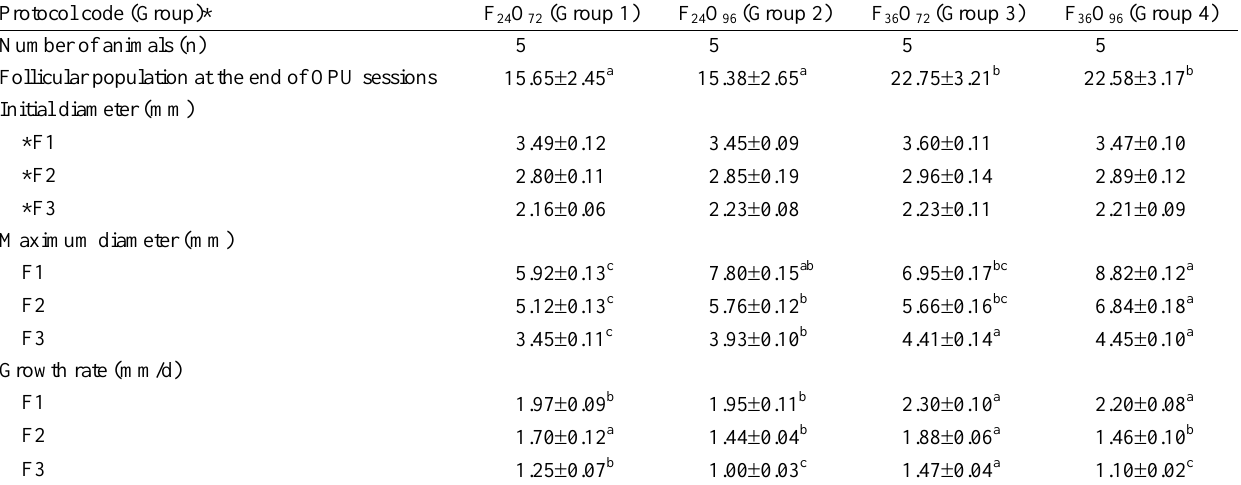
Table 1. Ovarian follicular development (Mean  SEM) after undergoing repeated superstimulation of ovarian follicular growth and OPU in Thai native heifers Protocol code